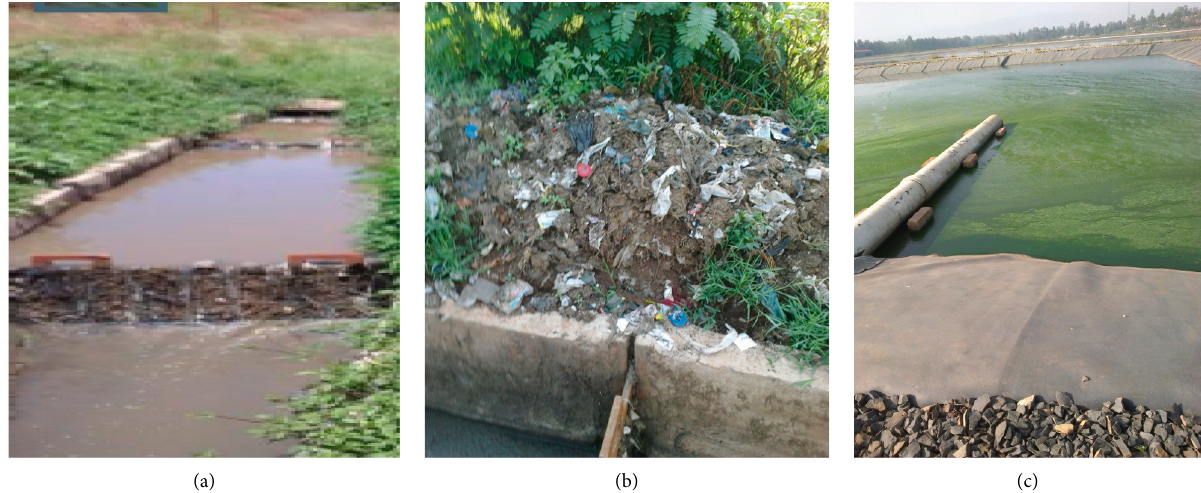
Figure 3: WSP of Kito Furdisa Campus, Jimma University, Jimma town, Southwest Ethiopia, 2020 (photos were taken by the first